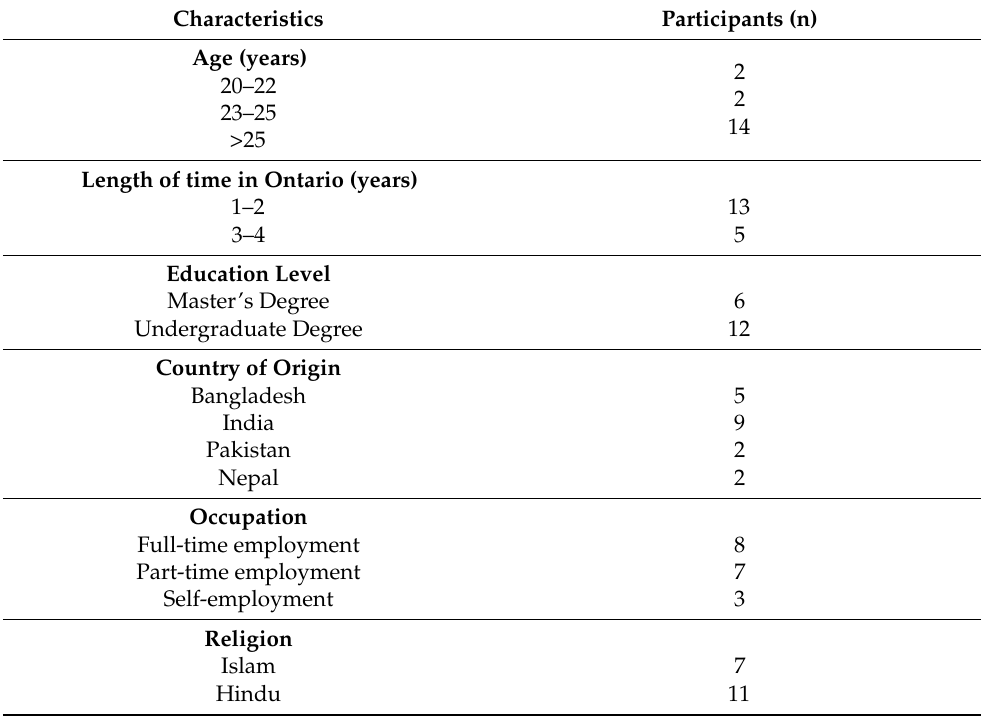
Table 1. Sociodemographic characteristics of all